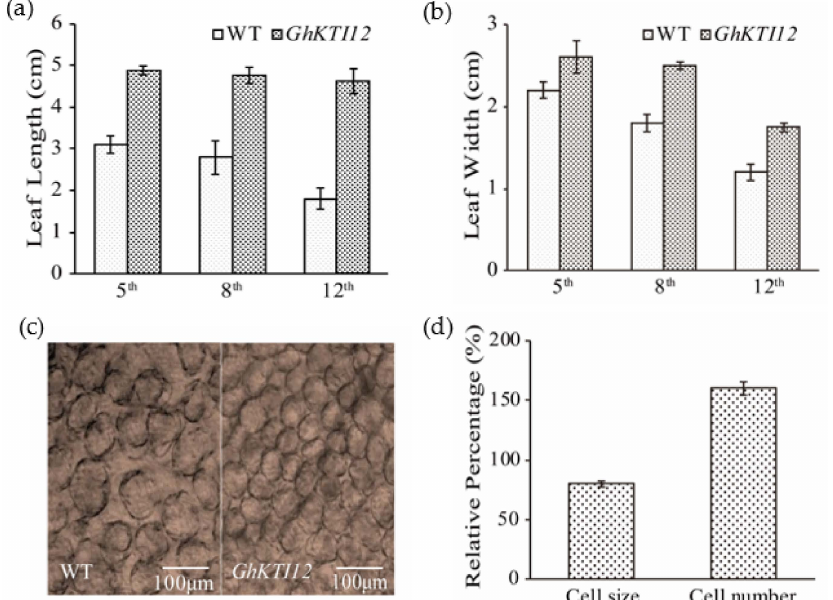
Figure 3. Effect of GhKTI12 on tobacco leaf development. ( a , b ) Comparison of leaves size from three different positions (5th, 8th, and 12th) between WT and GhKTI12 transgenic plants from 4-month-old plants, the leaf length and leaf width were measured (n = 10). ( c ) Microscopic observation of palisade cell in the upper epidermis of third leaf in wild type and transgenic plant. (Bars = 100 um.) (n = 5). ( d ) Relative percentage of epidermis palisade cell number and cell size in GhKTI12 transgenic tobacco compared with wild type (n = 10). All data was taken from T2 generation. Bars in the graph show the standard mean error. Asterisks indicates significant differences between wild type (WT) and GhKTI12 transgenic plants analyzed by Student’s t -test, p <